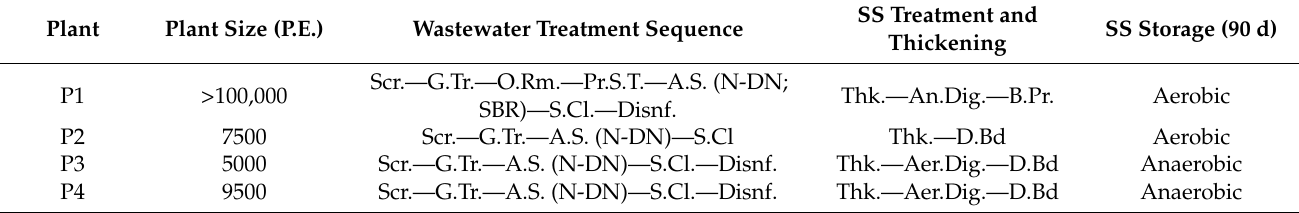
Table 1. Sewage sludge samples: WWTP, sewage sludge (SS) treatment sequence, and SS storage conditions. Plant Plant Size